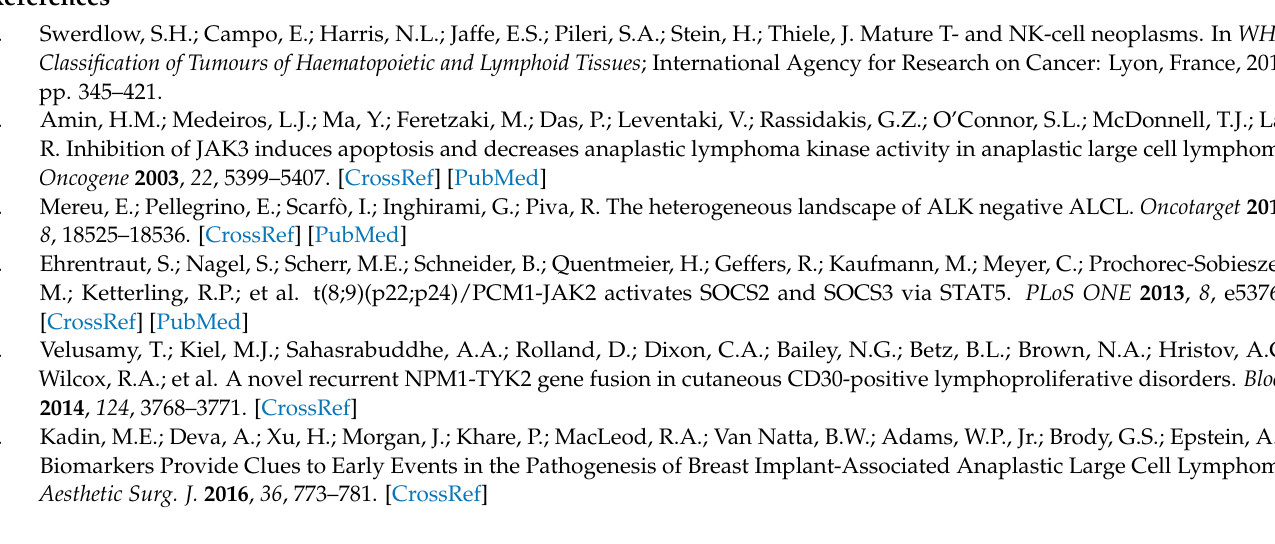
Table S2: Differential expressed genes in BI-ALCL vs cALCL; Table S3: Enrichment analysis of UP- and DOWN regulated genes in BI-ALCL vs cALCL; Table S4: Differential expressed genes in cALCL vs ALK+sALCL; Table S5: Enrichment analysis of UP- and DOWN regulated genes in cALCL vs ALK+sALCL; Table S6. TYK2 expression levels in cALCL; Table S7: Differential expressed genes in BI-ALCL vs ALK+sALCL; Table S8: Enrichment analysis of UP- and DOWN regulated genes in BI-ALCL vs ALK+sALCL. Figure S1: DUSP22 and IRF4 expression in cALCL and